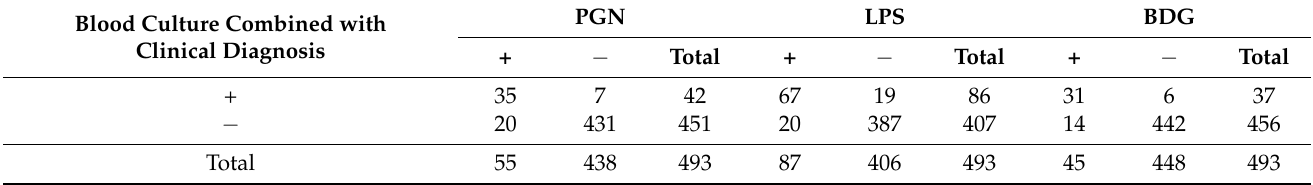
Table 2. Results of the blood culture combined with the clinical diagnosis and the efficacy of PGN, LPS, and BDG in the diagnosis of BSIs.